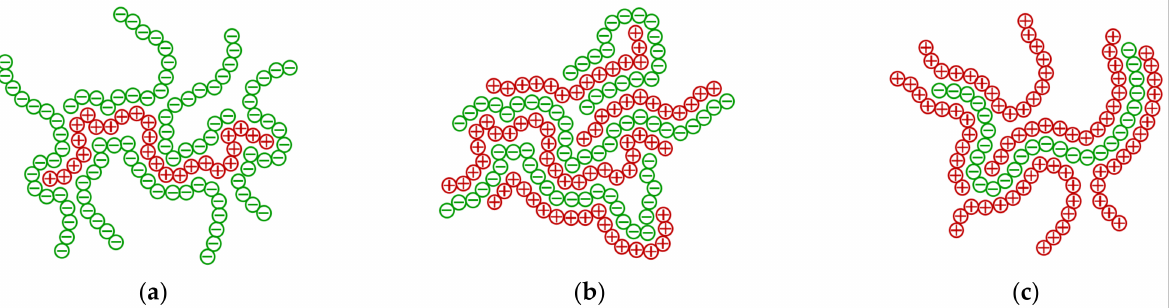
Figure 5. Scheme of the polyelectrolyte complexation: ( a ) carrageenan in excess; ( b ) equimolar mixture; ( c ) polyDADMAC in